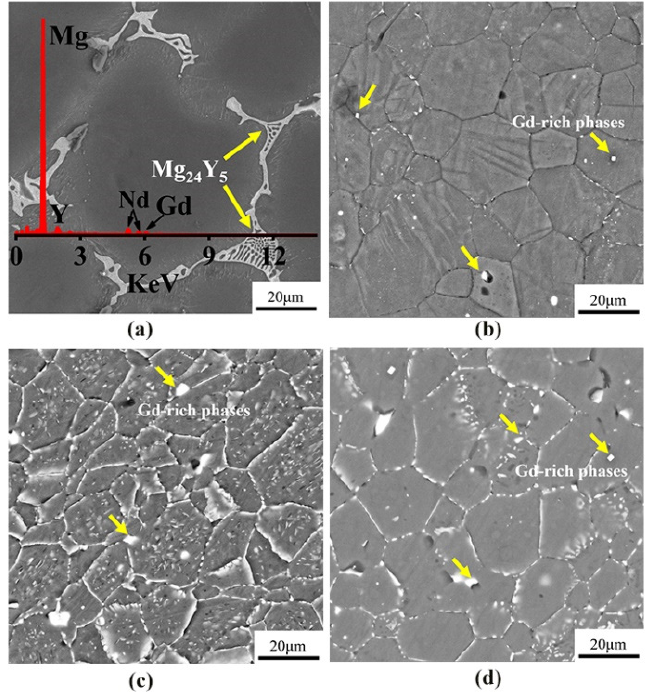
Figure 3. The SEM images of WE43 in ( a ) as-cast, ( b ) cold-rolled, ( c ) warm-rolled, and ( d ) hot-rolled condition.